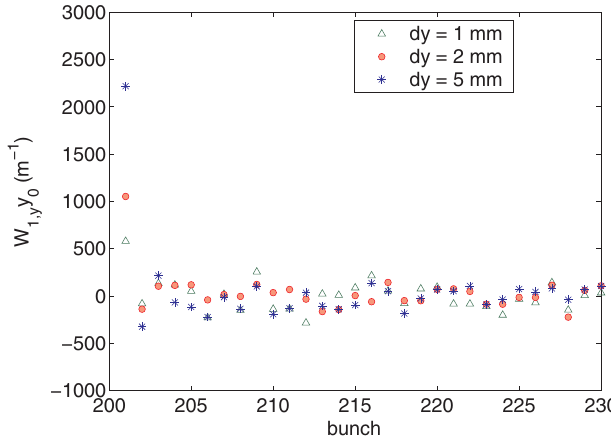
FIG. 4. (Color) Vertical wake force and cloud line density along the bunch train at KEKB. Bunch repetition is 8 ns. Three types of (cid:1) 1 , 2, and 5 mm. points are given for the displacement, y 0 Primary electrons are produced at a photon-illuminated position, 30% of them are produced uniformly on the chamber surface, (cid:1) 1 : 0 . and secondary electrons are produced with the rate, (cid:3) 2max to no more than the 210th bunch. The direction of the wake force is the same as that of the displacement—that is, it is a